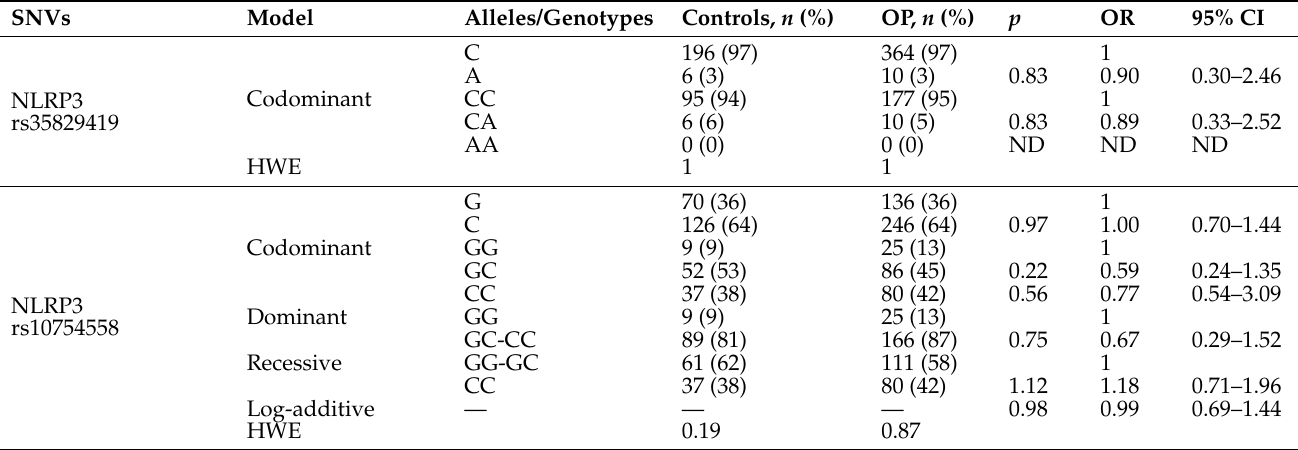
Table 2. Allele and genotype frequencies between OP patients and controls in SNVs of NLRP3